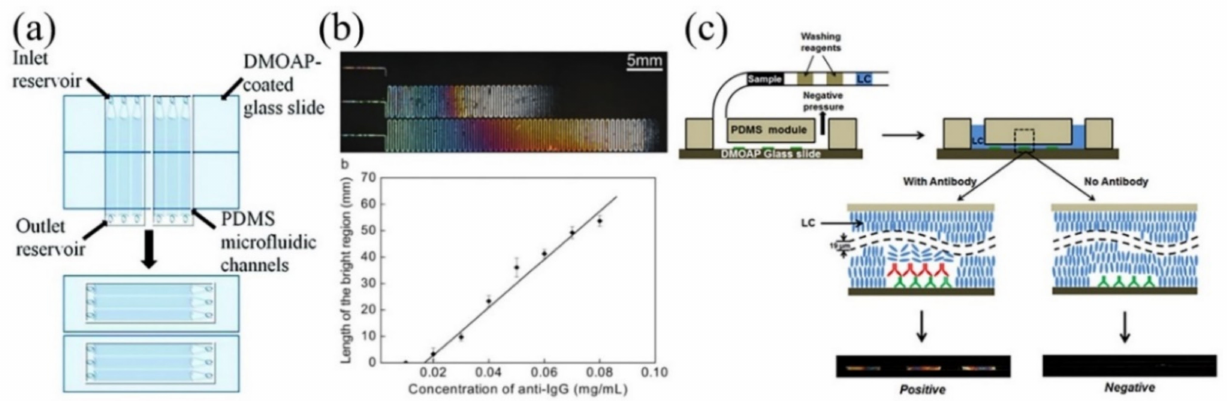
Figure 2. ( a ) Schematic illustrations of the preparation of LC-solid interface with microfluidic techniques for multiplex analysis. Reprinted with permission from ref. [69]. Copyright 2011 American Chemical Society. ( b ) Polarized optical microscopy images of IgG-decorated LC-solid interface-based microfluidic platform after the addition of anti-IgG of (from top) 0.02 mg/mL, 0.05 mg/mL, and 0.08 mg/mL, respectively, and the length of the bright region as a function of the anti-IgG concentration. Reprinted with permission from ref. [68]. Copyright 2009 John Wiley and Sons. ( c ) Schematic illustrations of the working principle of one-step LC-based microfluidic immunoassay. Reprinted with permission from ref. [67]. Copyright 2014